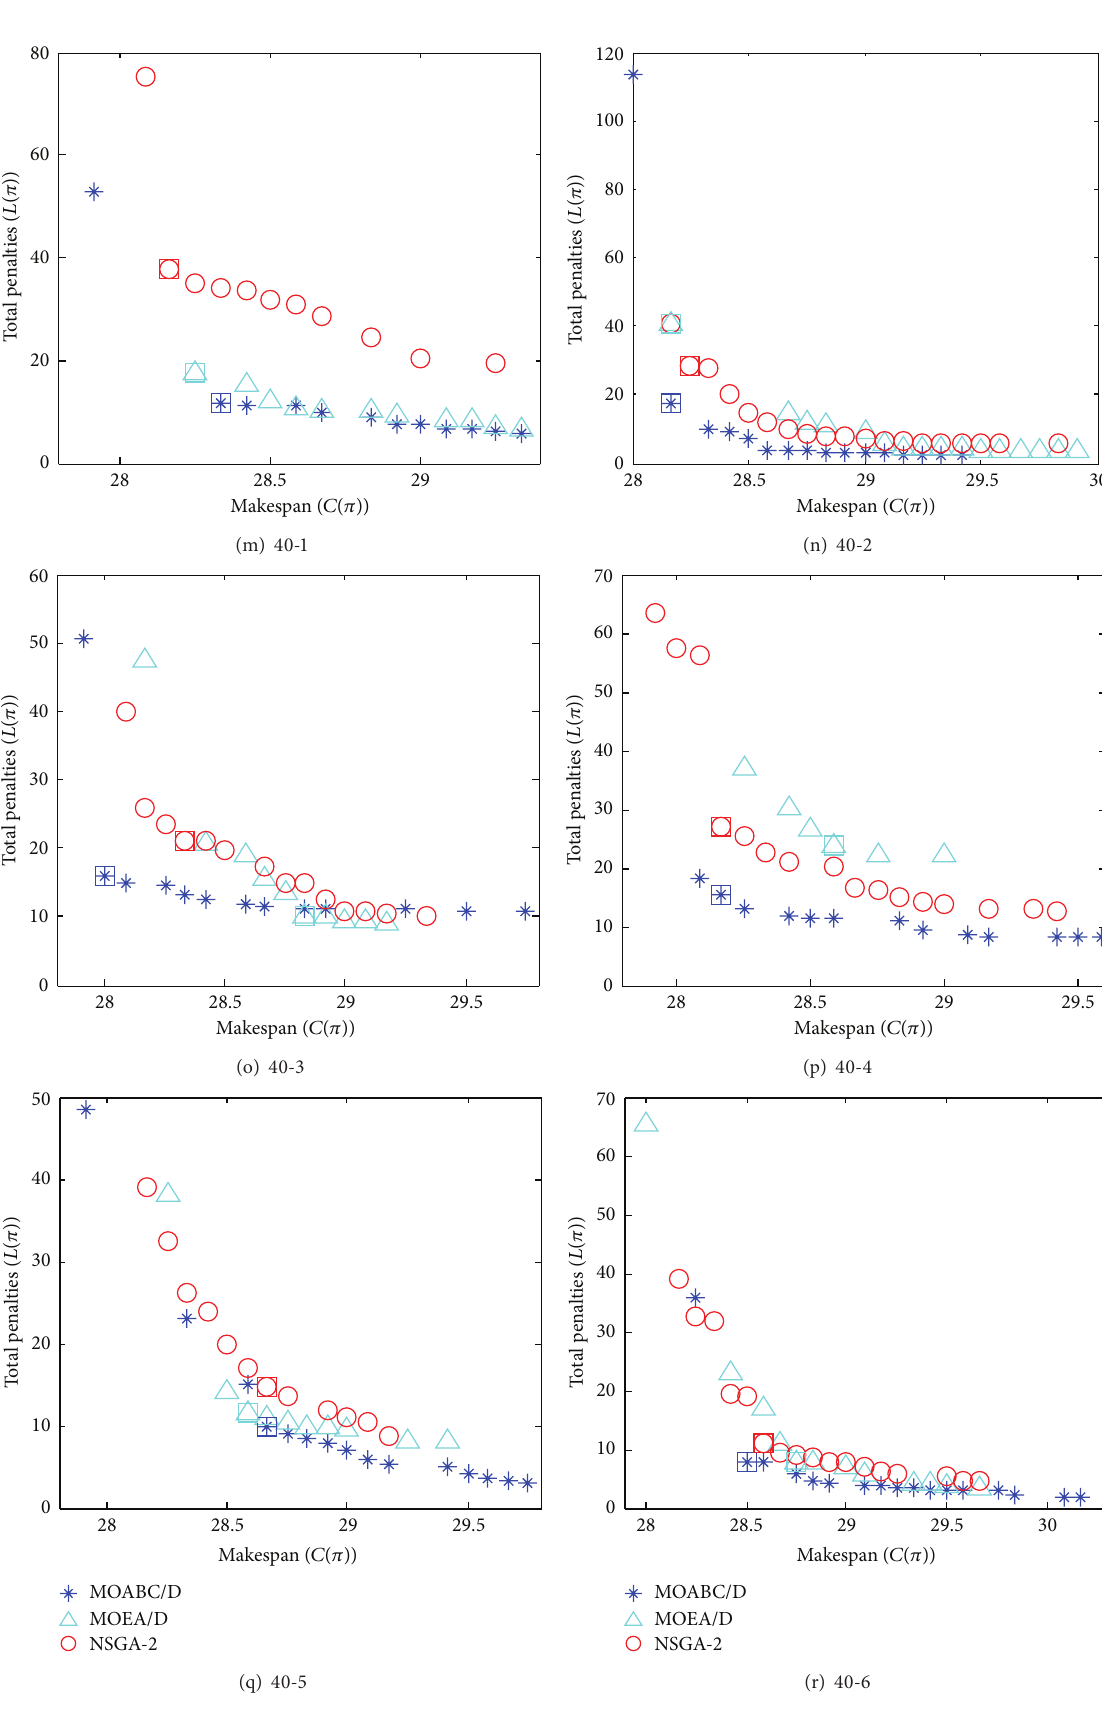
Figure 4: Pareto front obtained by MOABC/D, MOEA/D, and NSGA-II on instances (unit: